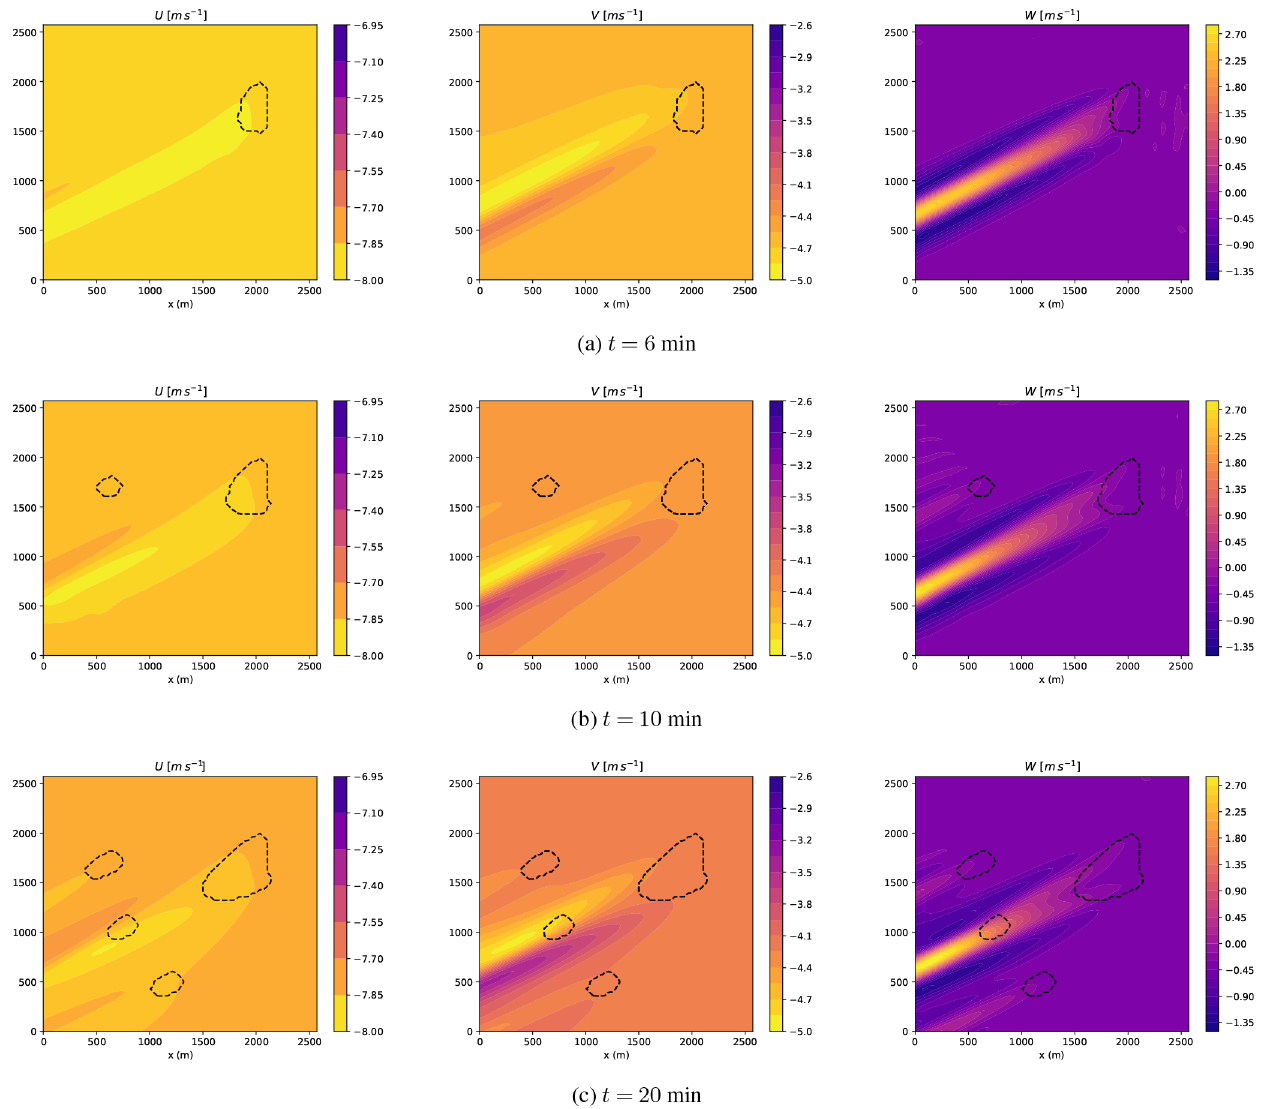
Figure 1. Wind vector components ( U , V W ) performed with WRF-SFIRE at times t = 6, 10 and 20min. The fire front is represented by a dashed